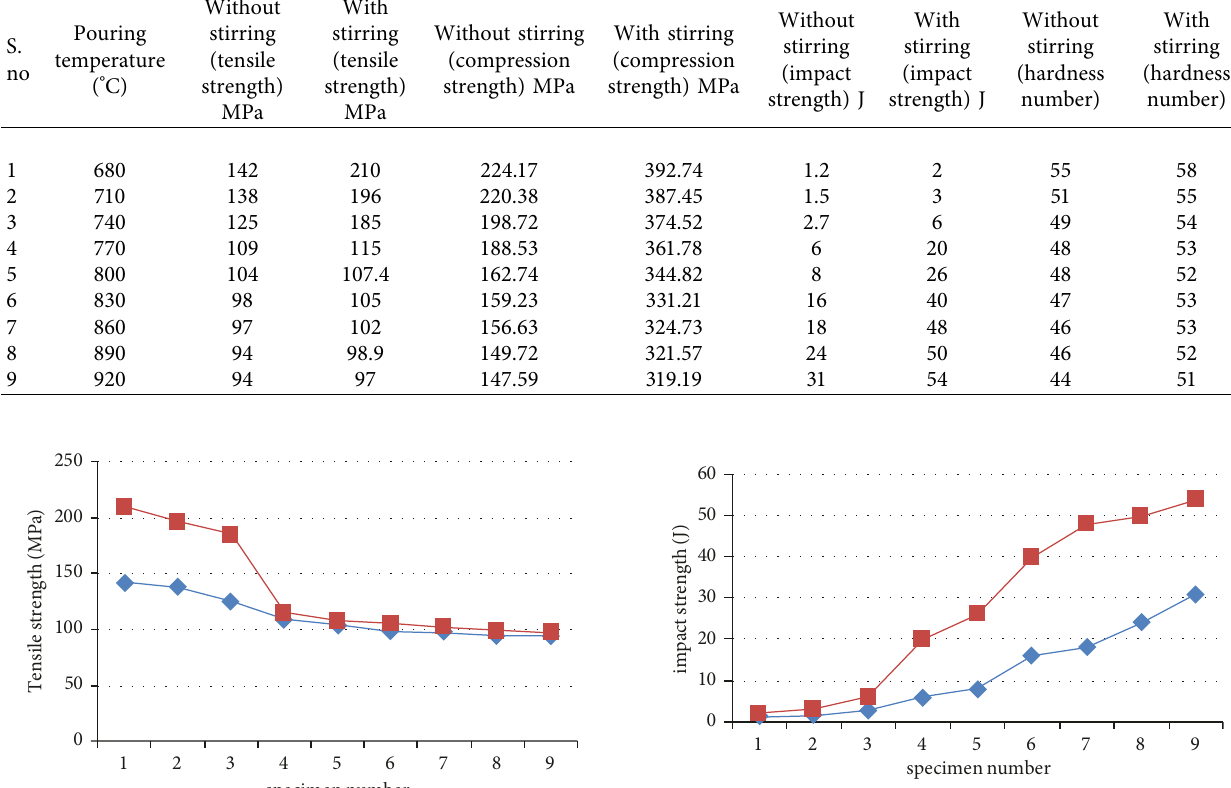
Table 6: List of results.